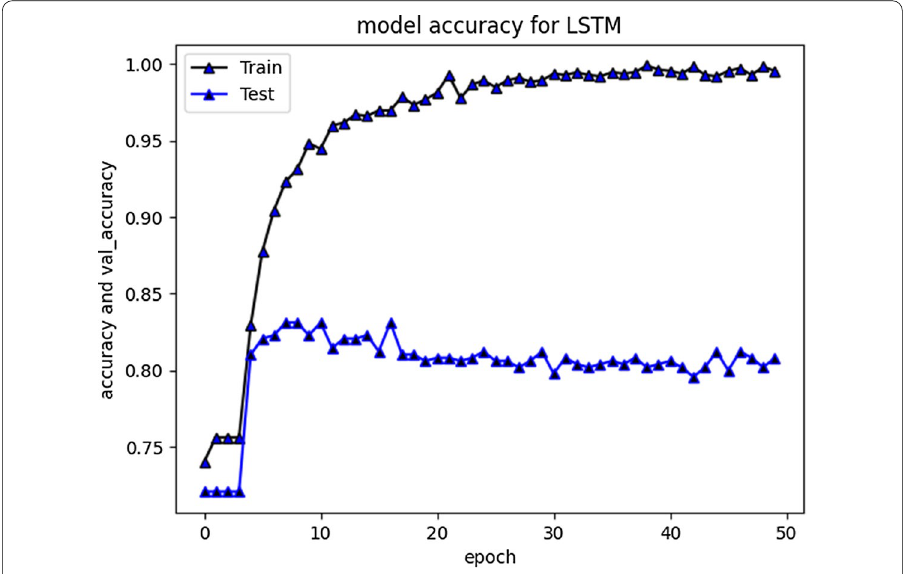
Fig. 6 RNN-LSTM Model accuracy graph for 50 epochs